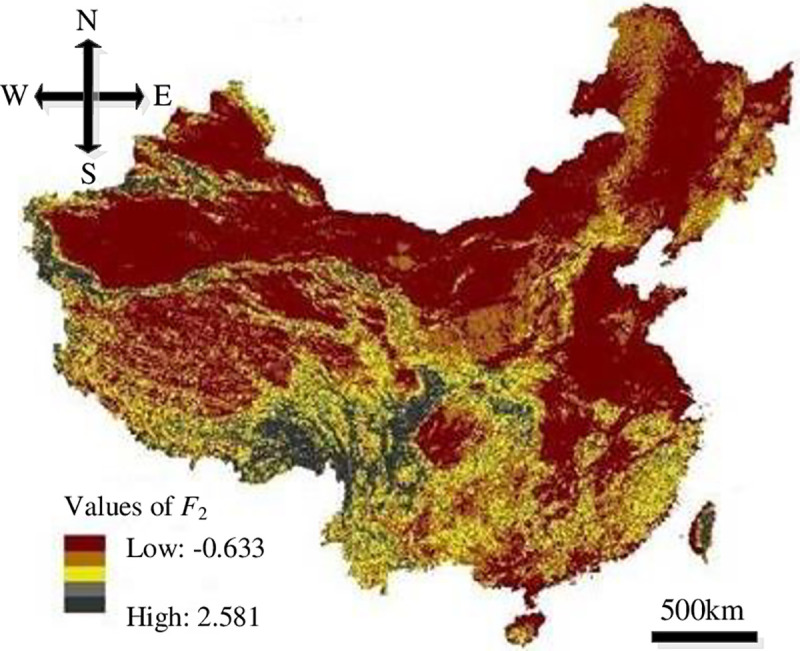
Distribution of F2.